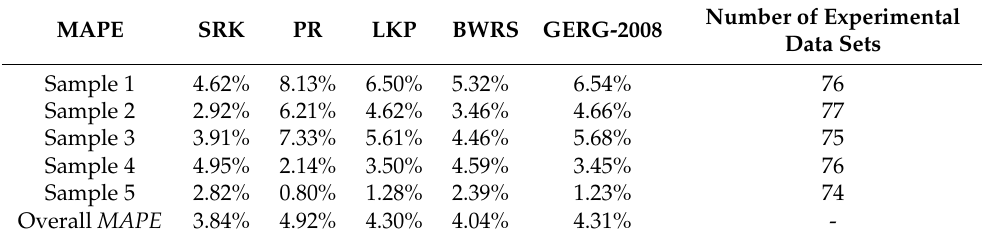
Table 5. MAPE s of experimental and calculated results in the gas density prediction.